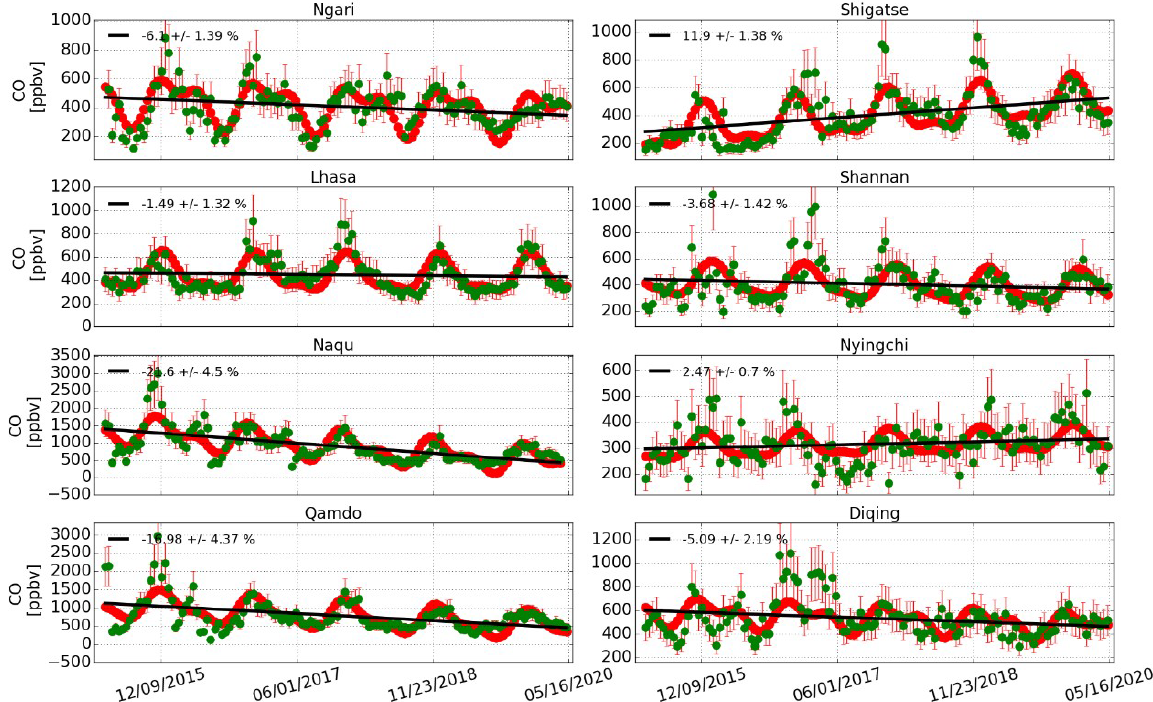
Figure 4. Interannual variabilities of surface CO from 2015 to 2020 over the HTP. Green dots are the biweekly mean of in situ surface CO measurements. Vertical red error bar is 1 σ standard variation within the respective 2 weeks. The seasonality and interannual trend in each city fitted by using a bootstrap resampling model with a third Fourier series (red dots) plus a linear function (black line) is also shown.